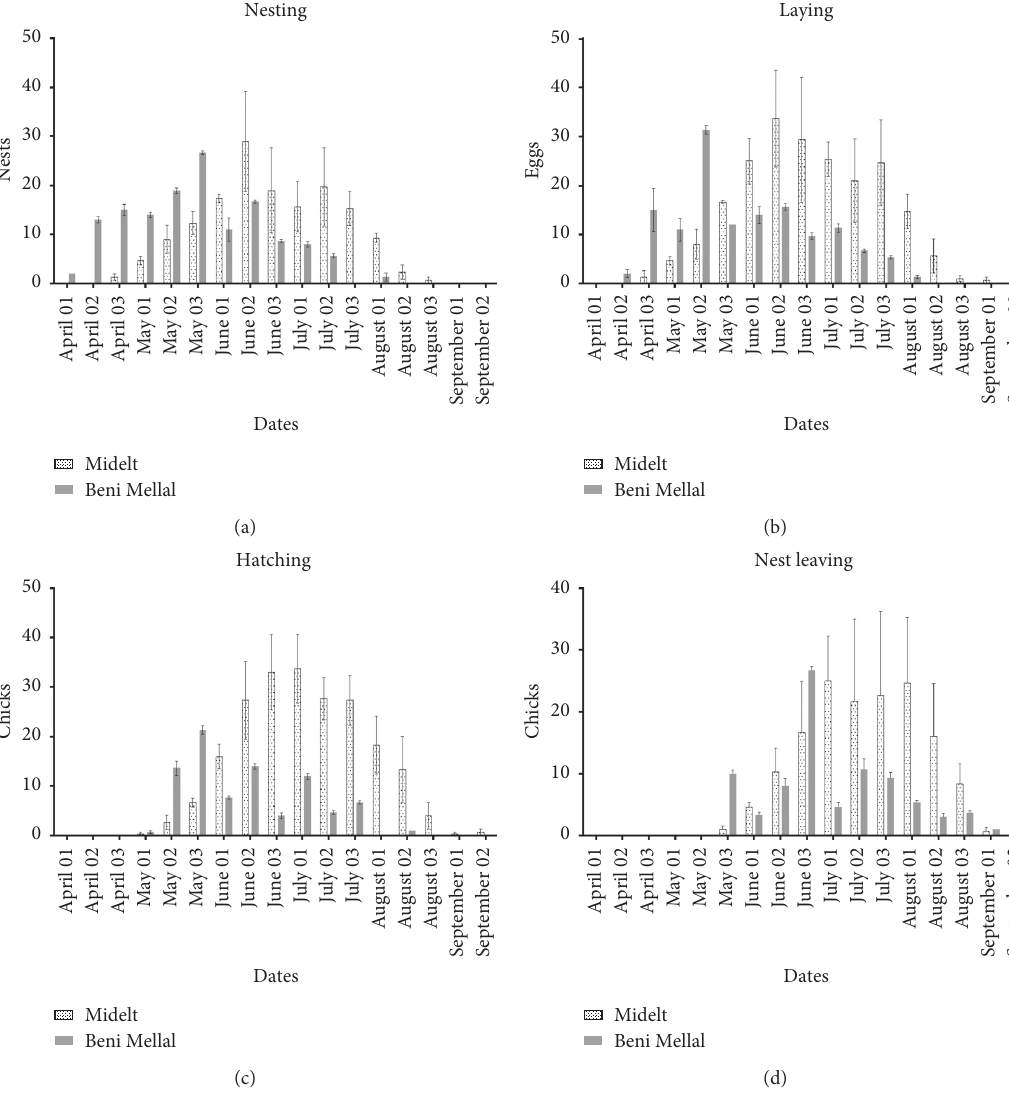
Figure 1: Breeding chronology of turtle dove at Beni Mellal and Midelt between 2015 and 2018. Table 2: Summary of the ANOVA test examining the difference